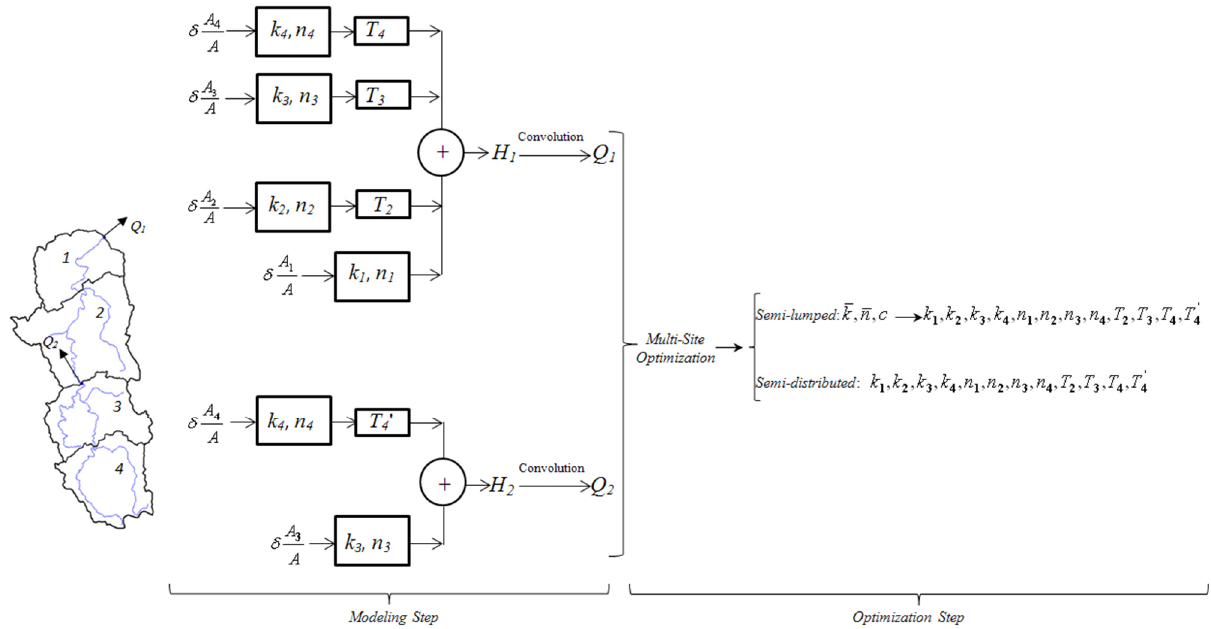
Figure 2. Schematic diagram of modified Geomorphological Unit Hydrograph based on Nash’s model (GUHN)